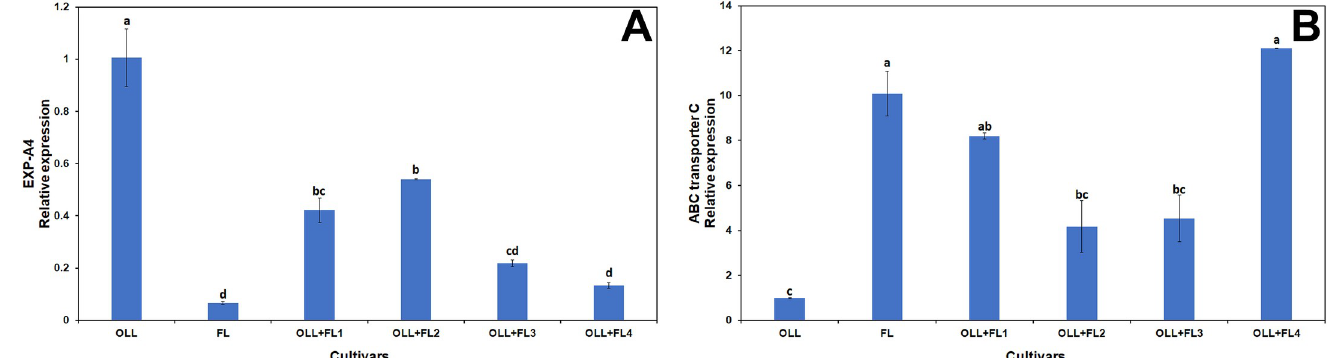
Fig 8. Relative expression of EXP-A4 (A) and ABC transporter C (B) transcripts in OLL8, finger lime (FL) and four selected OLL8+FL allotetraploids. Bars represent means ± standard error. Means separation by Tukey’s honestly significant difference test (P � 0.05).